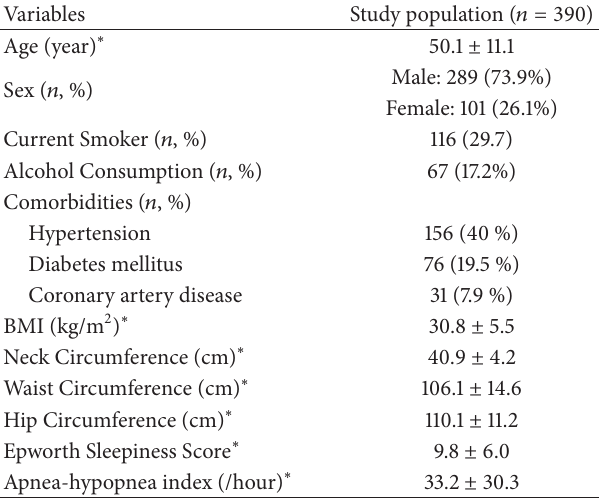
Table 1: Characteristics of the study population.